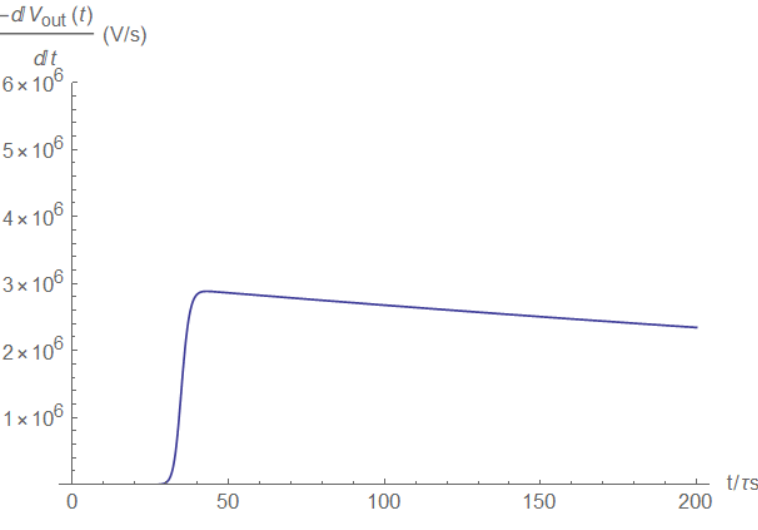
Figure A36. Load voltage derivative.